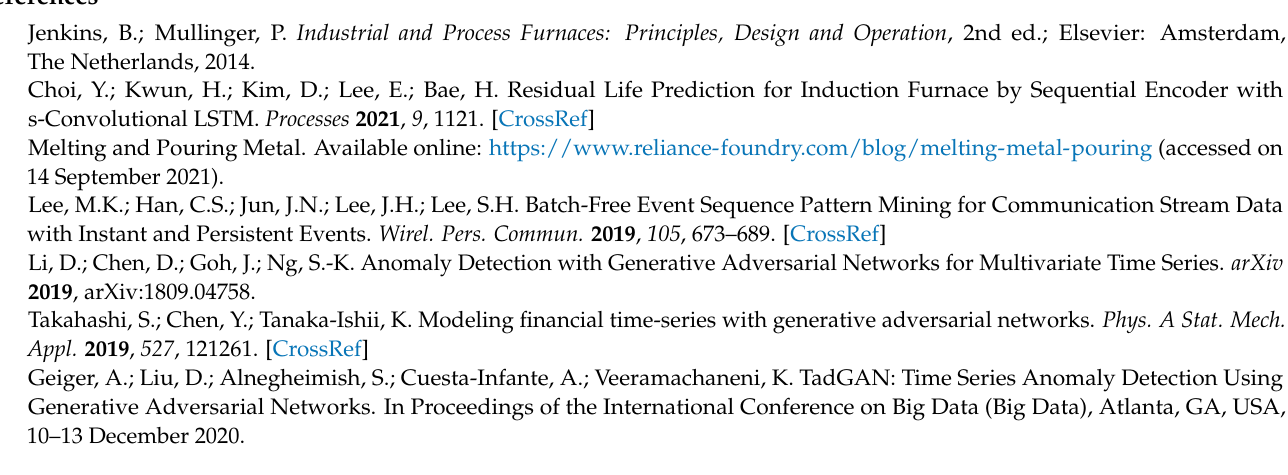
Figure A4. Implementation details of the generator model for the casting process.